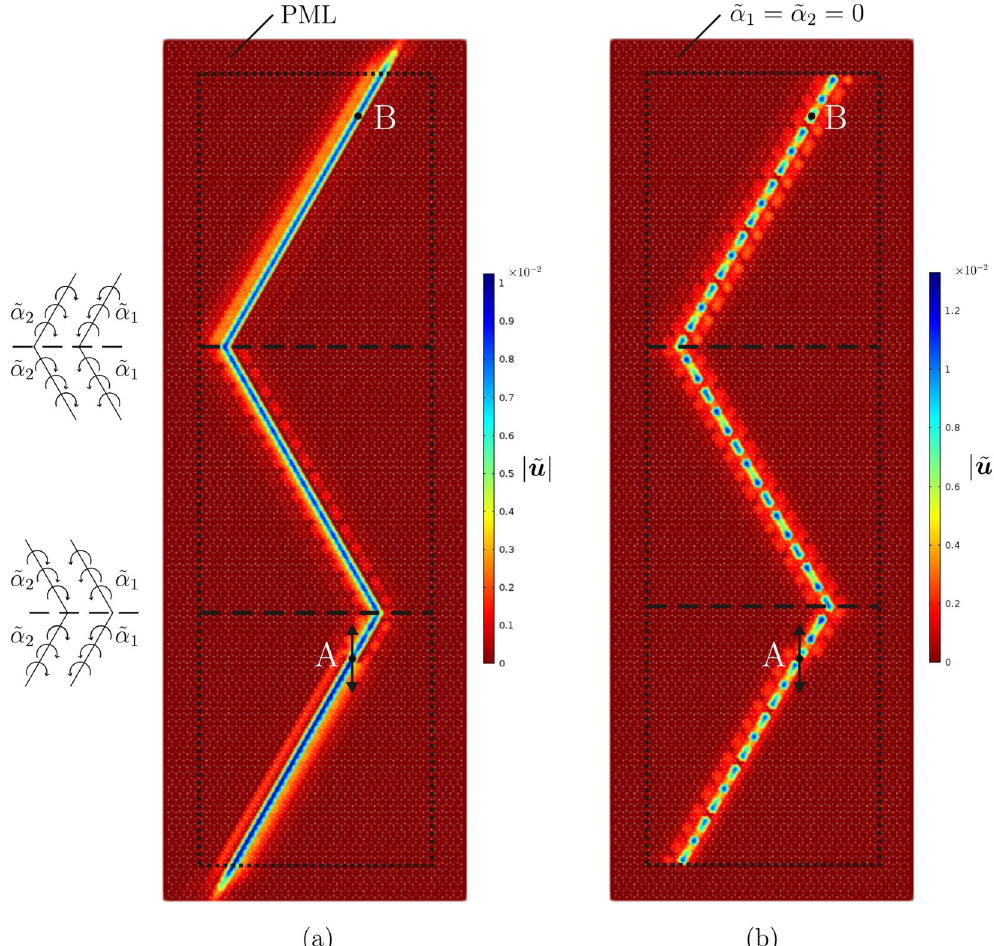
Figure 7. Bending of a Gaussian beam in a lattice with spinner constants α = .  0 8 at = .  f 0 858, GB when the medium is surrounded by ( a ) PML or ( b ) a lattice without gyros. The insets on the left show how the spinners are arranged in proximity of the interfaces, indicated by dashed